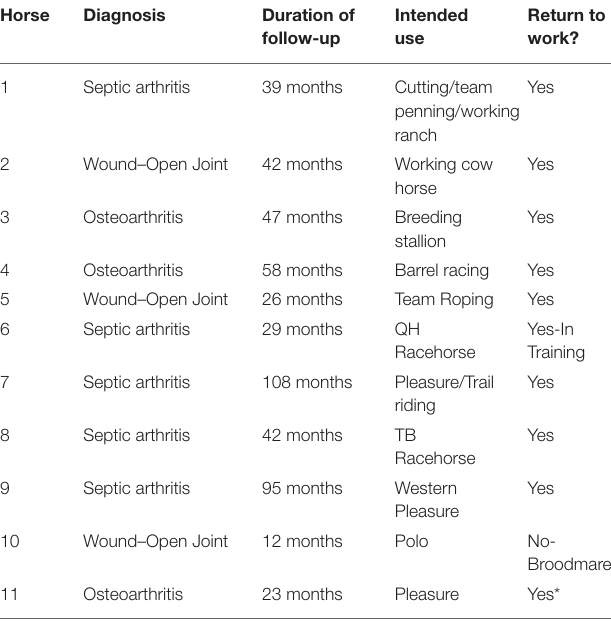
TABLE 4 | Follow-up and intended